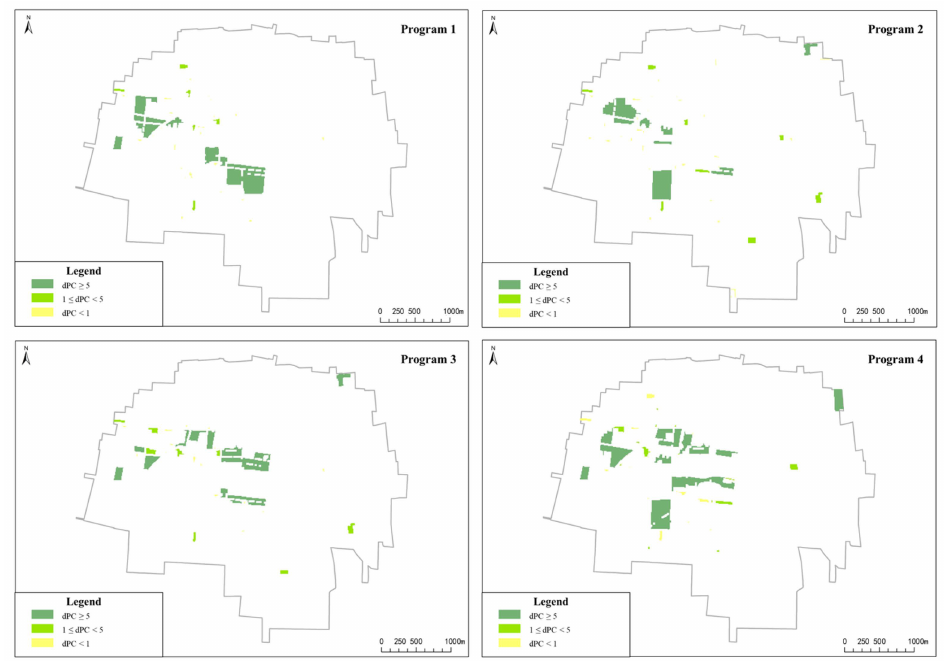
Figure 5. Identification of ecological sources for alternative planning programs in Zepan Village.